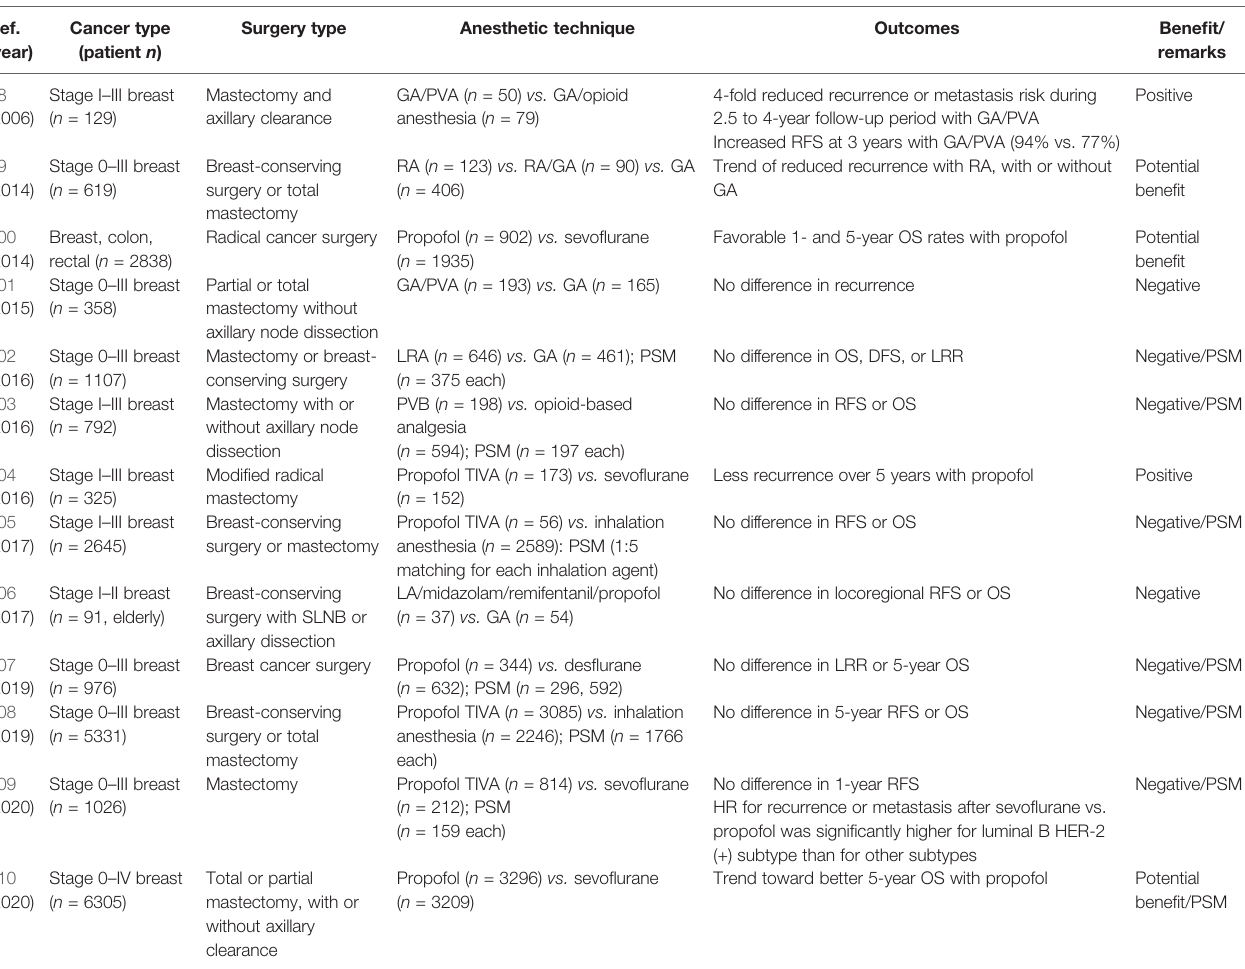
TABLE 1 | Retrospective analyses of anesthetic technique and breast cancer recurrence. Ref.